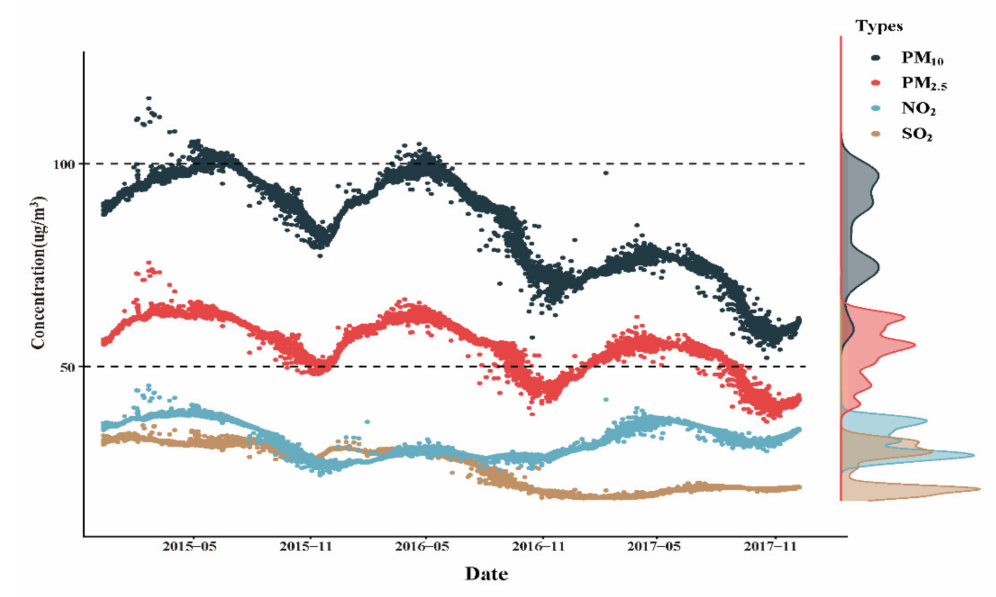
Figure 2. Ambient air pollution exposure to all participants, Shiyan, China, January 2015 to December